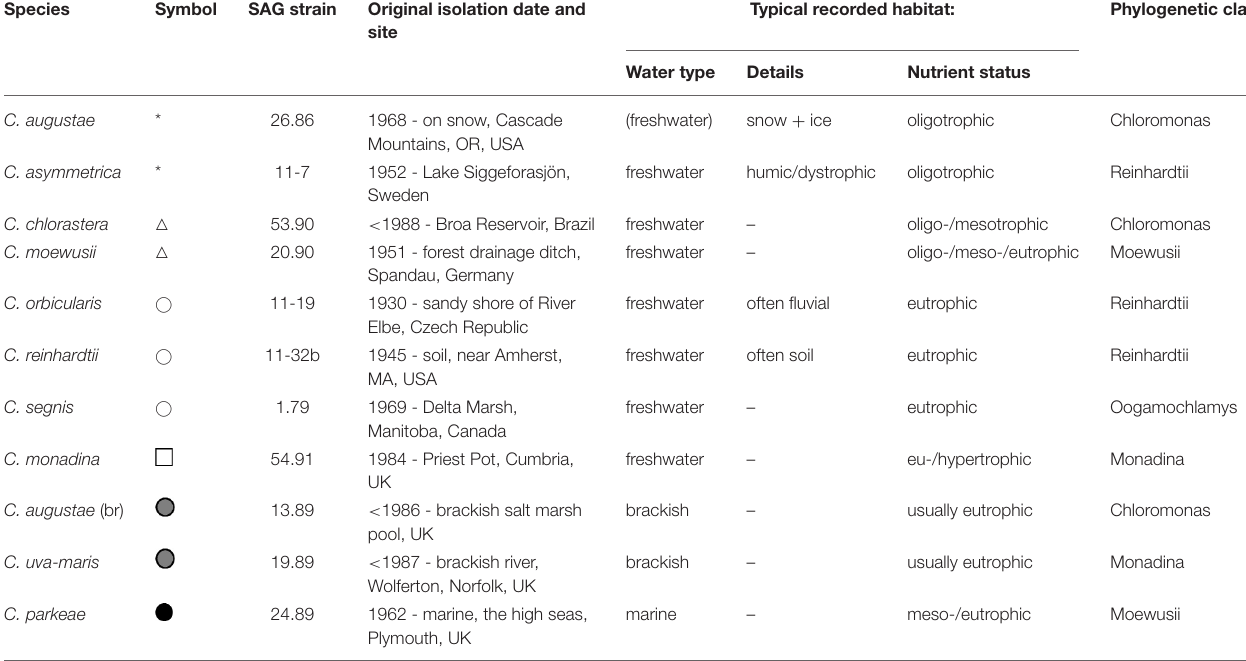
TABLE 1 | The eleven contrasting species of Chlamydomonas used in this study. Species Symbol SAG strain Original isolation date and Typical recorded habitat: Phylogenetic site